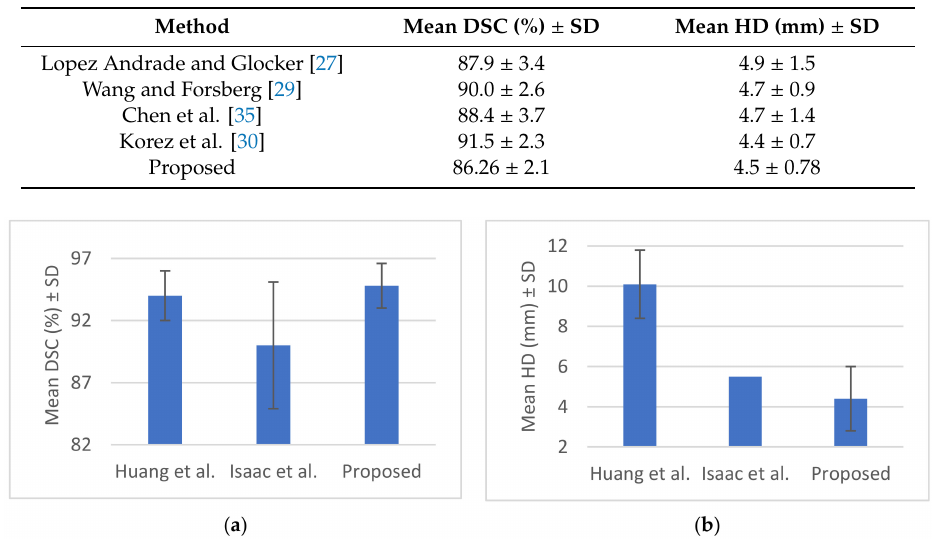
Figure 9. ( a ) Mean Dice similarity coe ffi cient (DSC) (%) ± SD, ( b ) mean Hausdor ff distance HD (mm) ± SD from Table